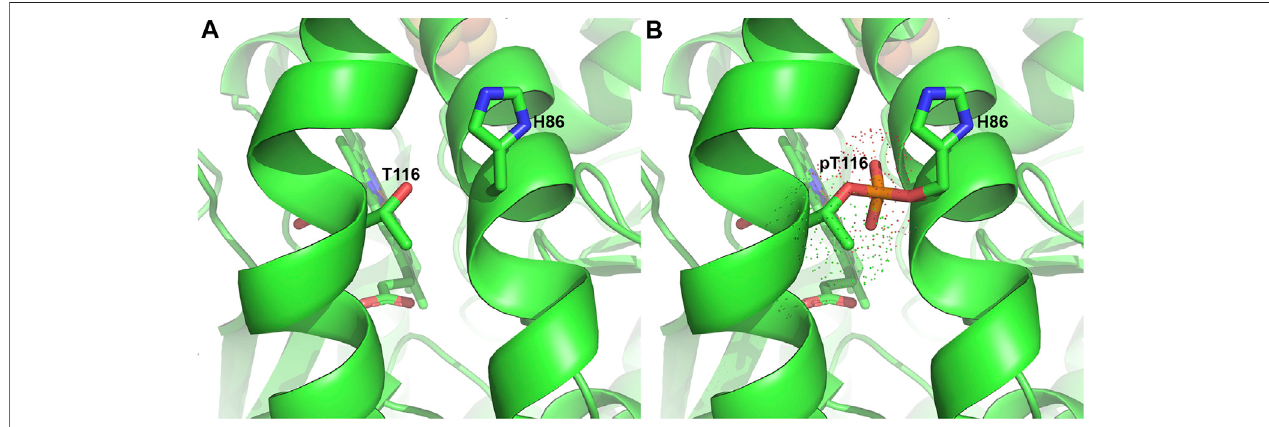
FIGURE 5 | Phosphorylation of T116 in Ferrochelatase. (A) Cartoon representation of the human ferrochelatase (PDB ID 2QD2) without any modi fi cation at T116, shownassticksandlabeled. (B) T116withcovalentlyboundphosphategroup,showninorange,atT116overlappingH86,shownassticksandlabeled.Dotsrepresent the electron density of pT116. Modeled using Vienna-PTM (Margreitter et al., 2013) and fi gure created using PyMOL Molecular Graphics System (Schrodinger,